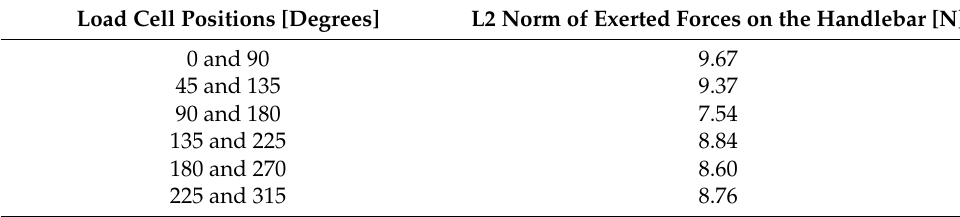
Table 2. L2 norm values for pairs of load cell positions rotated by 90 degrees.